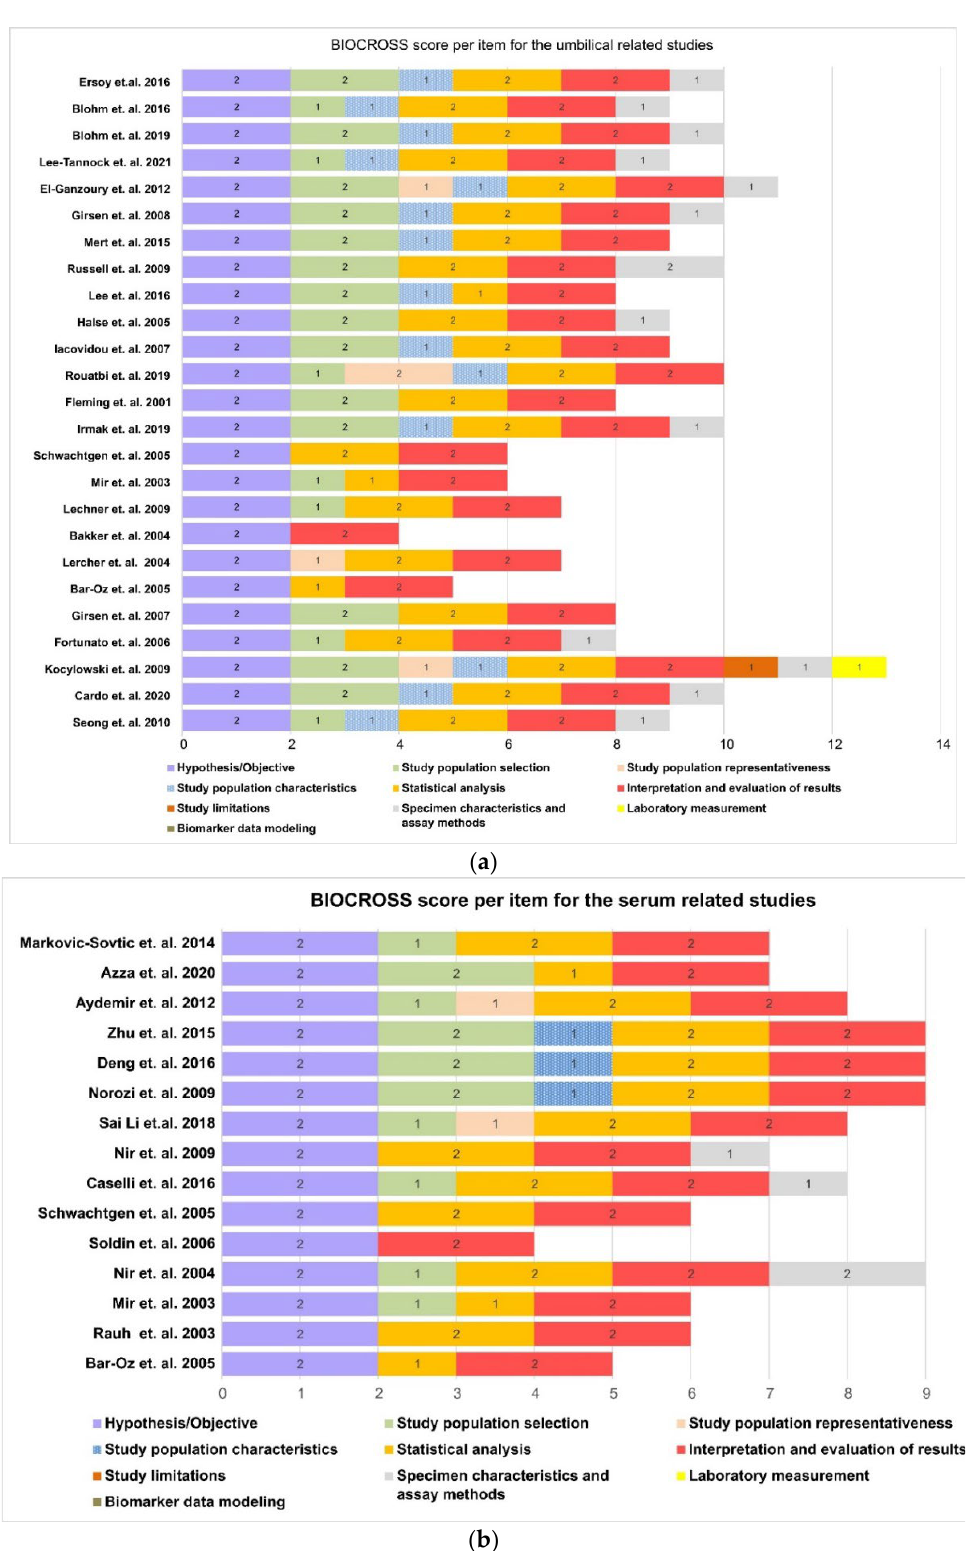
Figure 4. ( a ) Biocross evaluation tool for the assessment of the umbilical cord studies [16–40]. ( b ) Biocross evaluation tool for the assessment of the serum studies [21,25,26,41–52]. Articles that obtained low scores displayed underlying errors or defects particularly concerning the description of exclusion criteria, specimen characteristics, assay methods,